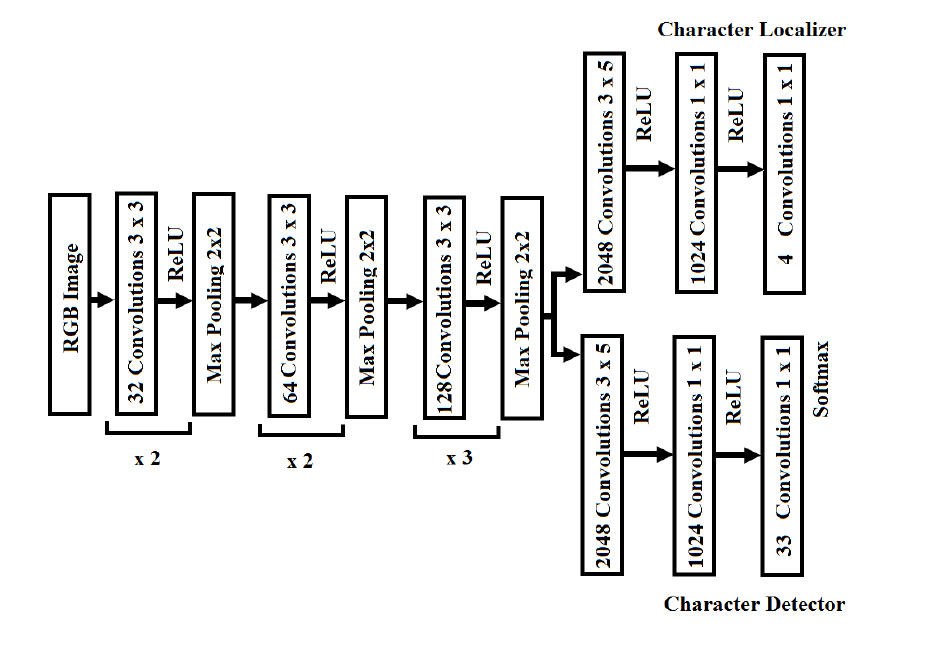
Figure 2. Character detector and